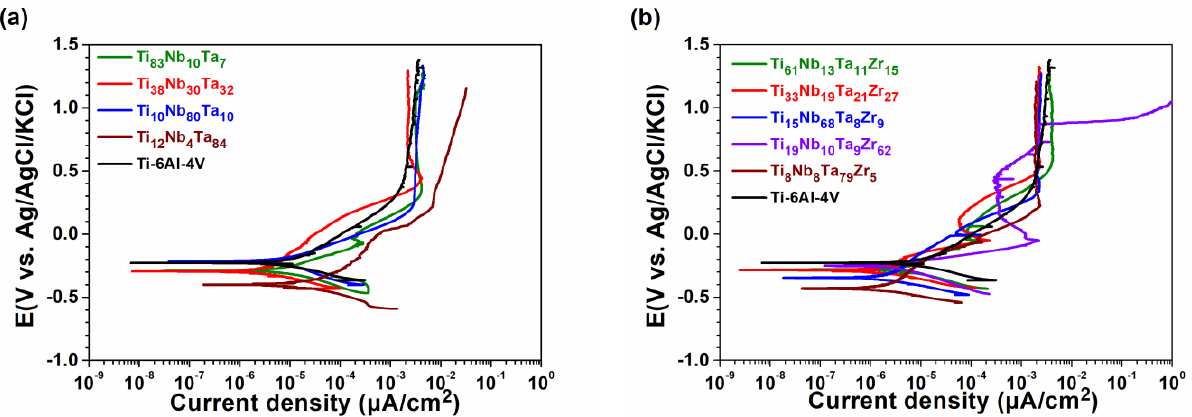
Figure 4. Potentiodynamic polarization curves of ( a ) TiNbTa and ( b ) TiNbTaZr films and the Ti-6Al-4V substrate in a 3.5 wt.% NaCl aqueous solution. Table 3. Corrosion characteristics of the Ti-6Al-4V substrate and TiNbTa(Zr) films.